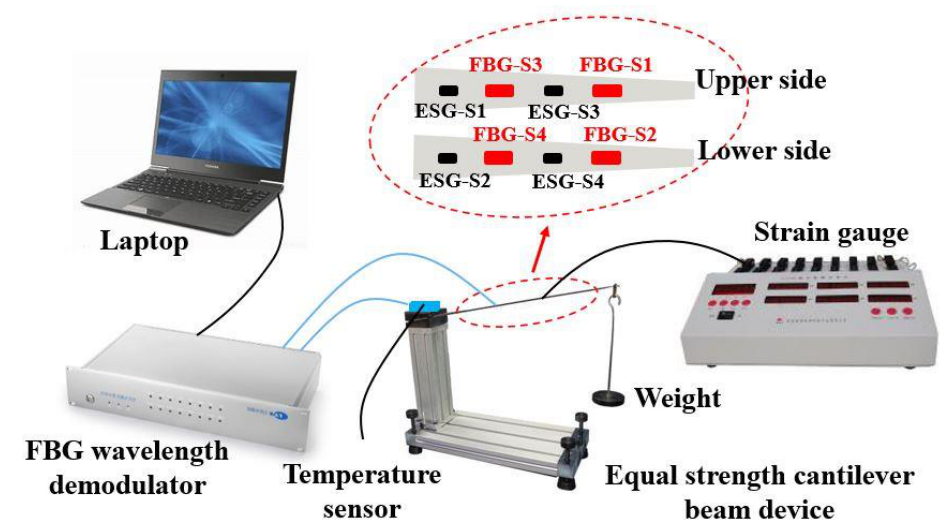
Figure 7. Schematic of the experimental setup for strain measurements.